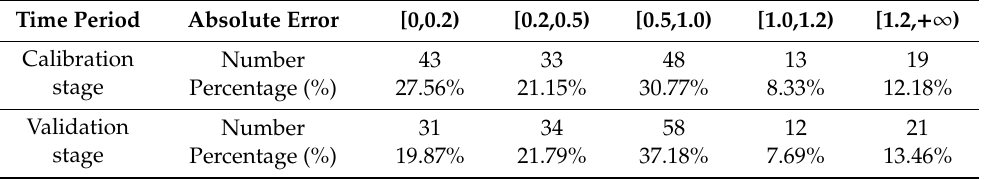
Table 4. Number and proportion of absolute errors of simulated and measured groundwater